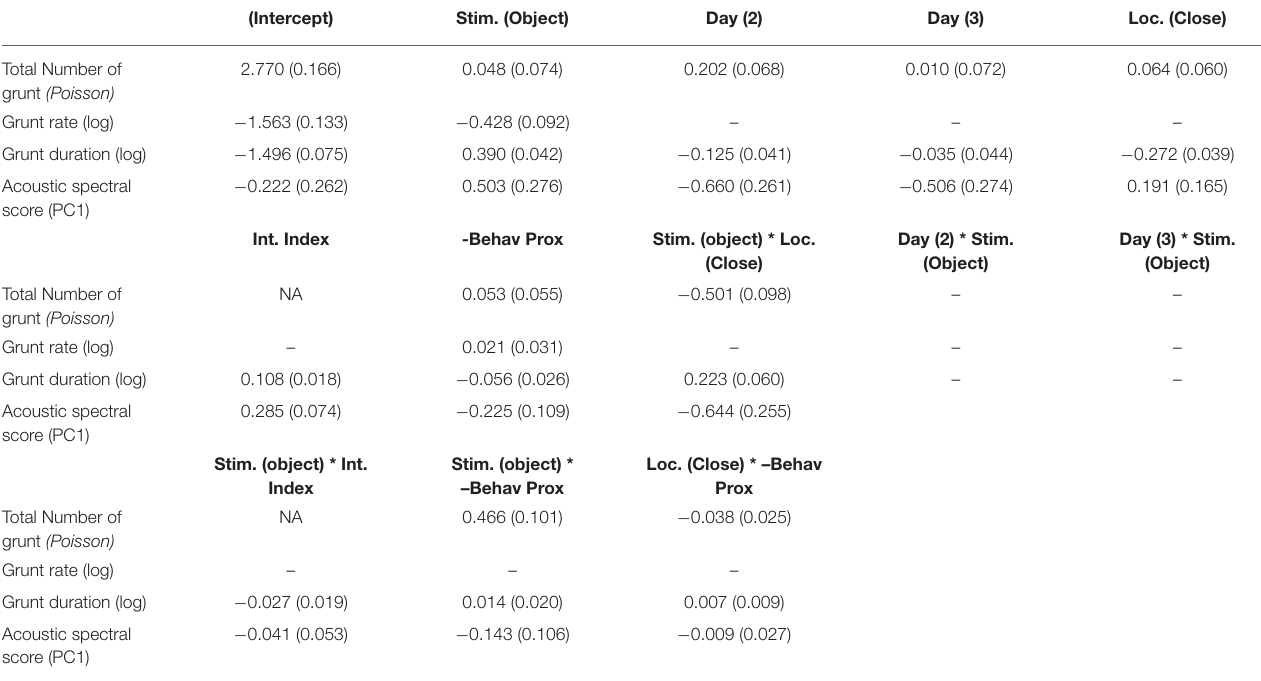
TABLE 8 | Estimates (standard error) of terms contained in the equivalent best selected